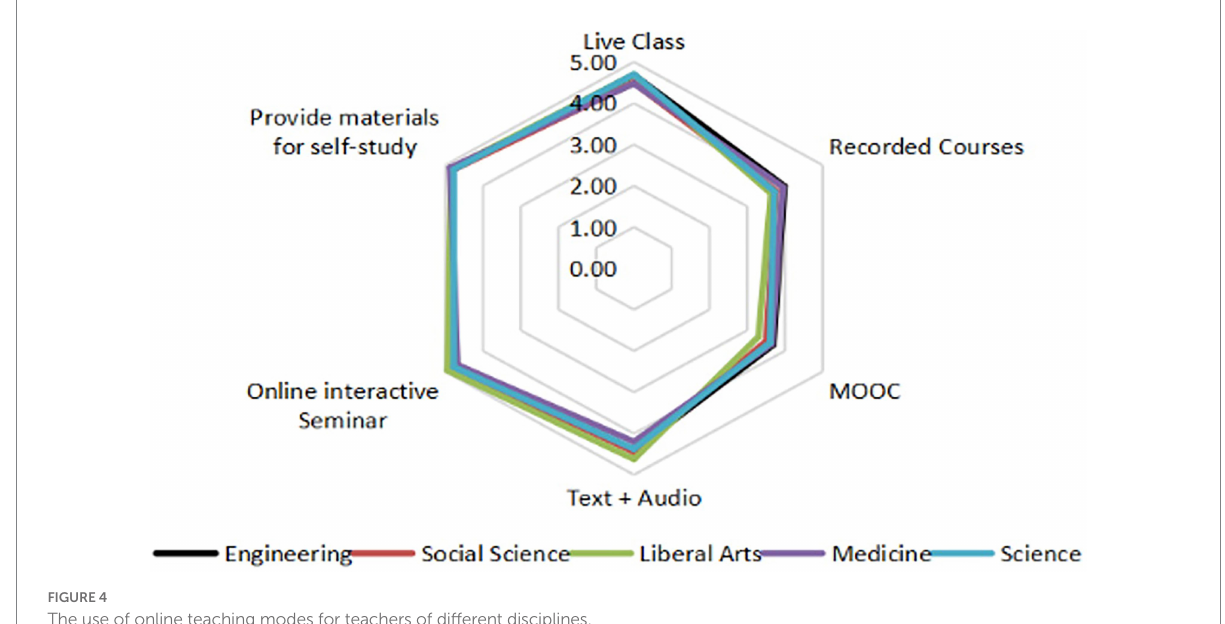
FIGURE 4 The use of online teaching modes for teachers of different disciplines.